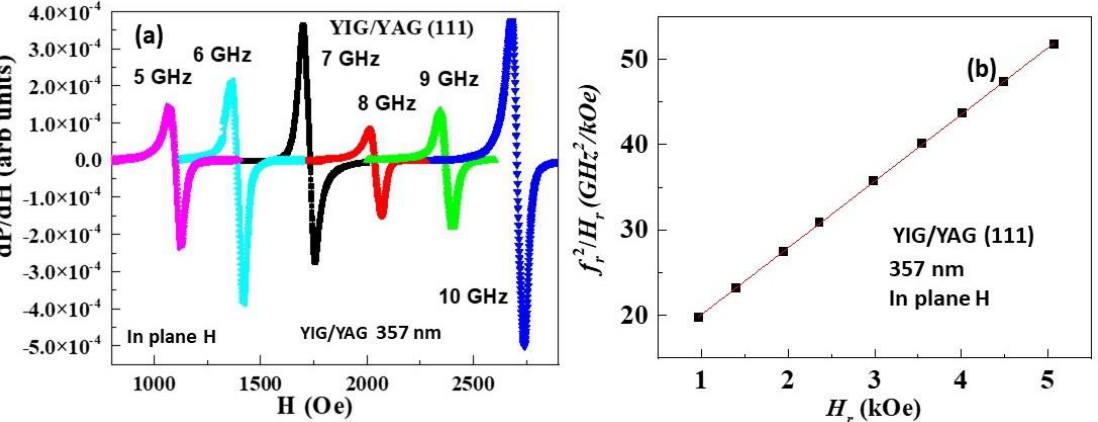
Figure 6. ( a ) Profiles of dP/dH vs. H showing FMR in 357 nm-thick YIG/(111) YAG for H applied parallel to film plane. ( b ) Theoretical fit to data on resonance frequency f r and field H r for estimation of magnetic parameters for the film.